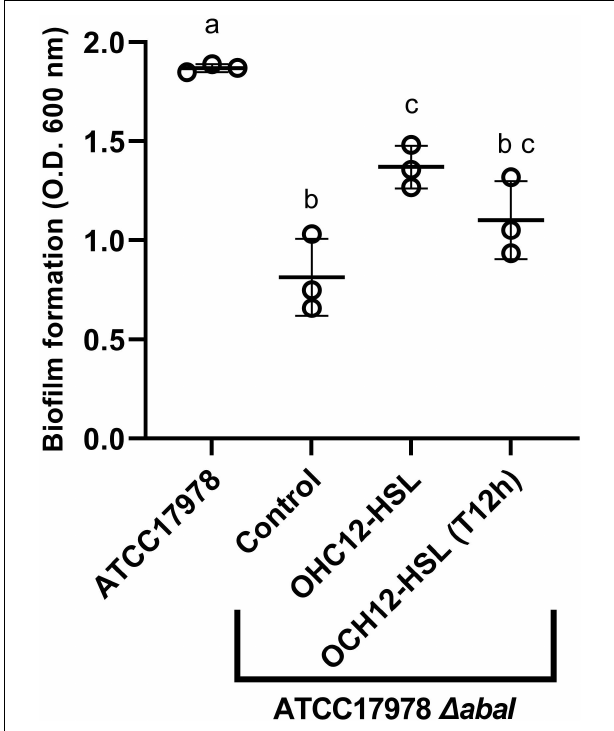
FIGURE 3 | Biofilm formation by A. baumannii ATCC R (cid:13) 17978 TM and its (cid:49) abaI mutant as measured with crystal violet staining. The capacity of OHC12-HSL (10 µ M) to restore the phenotype in the mutant was also tested. The addition of OHC12-HSL was performed at the beginning of the experiment and after 12 h of incubation (T12h). Biofilms ( n = 3) were inoculated in LS-LB, incubated at 37 ◦ C for 24 h and stained with crystal violet staining. Different letters indicate statistically significant differences (Mann–Whitney test, p < 0.05).